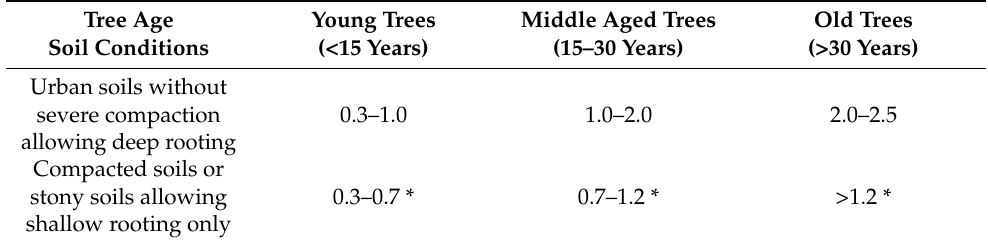
Table 4. Mean effective root depths (m) of the street trees, adapted from Wessolek in ATV-DVWK [33].